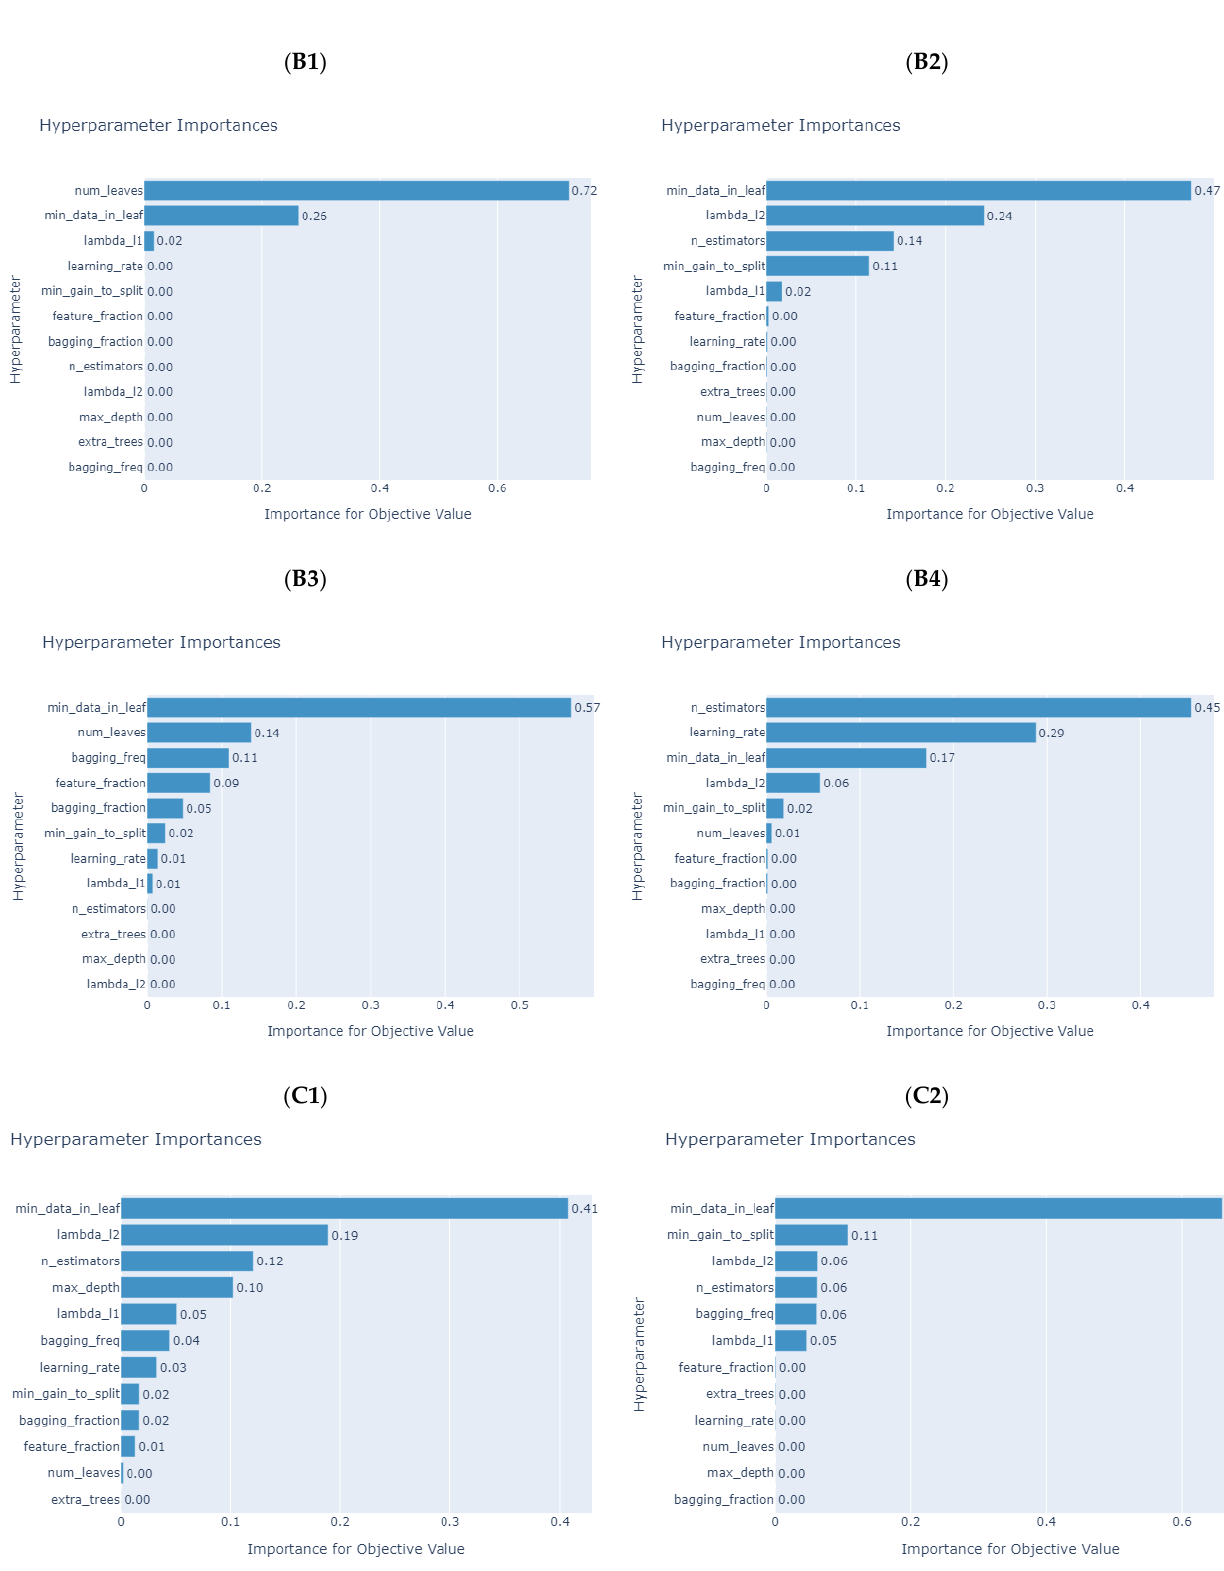
Figure 6. Hyperparameter importance of LightGBM models for product categories B and C (product B1 – B4, C1 – C2). Table 11. The RMSE and R2 results of the tree-based ML model prediction.